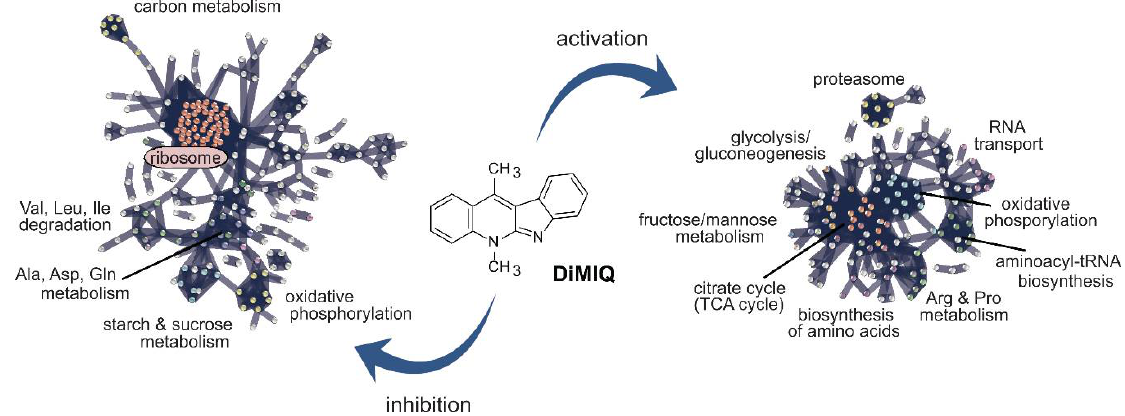
Figure 7. Visualization of major DiMIQ-induced alterations in metabolic pathway networks in the C. albicans biofilm cellular proteome. Interactions between proteins were predicted using the Search Tool for the Retrieval of Interacting Genes/Proteins (STRING).